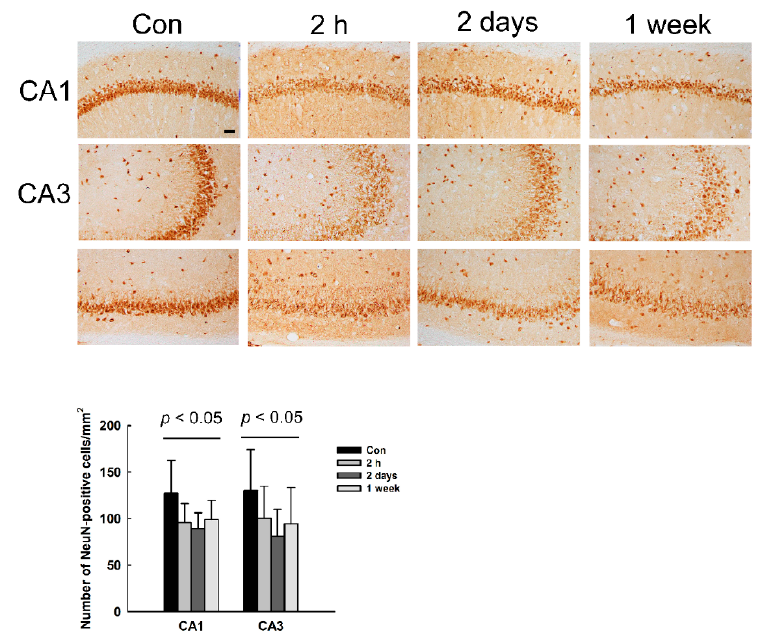
Figure 4. Immunoreactivity (IR) of neuronal nuclei (NeuN) in the hippocampus of NMDA-treated rats. NeuN-IR is observed in the nuclei of neurons. NeuN-positive cells were counted in the hippocampal CA1 and CA3 regions. The histogram presents the number of NeuN-positive cells per mm2 as the mean ± SD. Scale bars indicate 50 μ m.